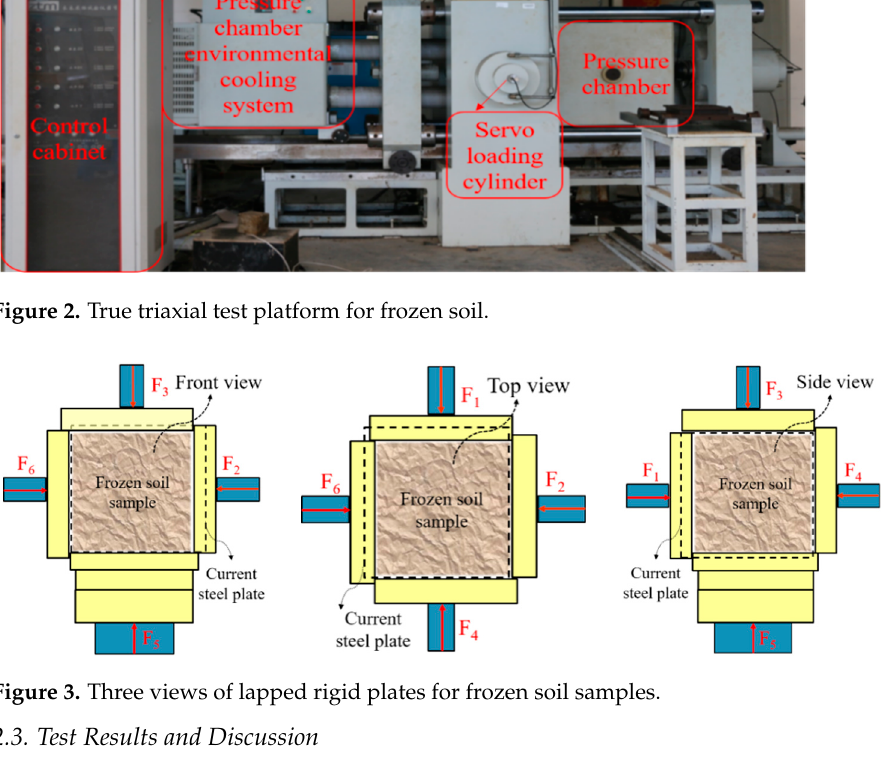
3 # Figure 4. True triaxial stress–strain and volume deformation curves of frozen calcareous clay. Figure 4 shows that the equivalent stress–strain relationship of the frozen calcareous clay was divided into three stages. The first was the linear elastic stage. Due to the high water content in the three selected samples, the samples were consolidated and frozen for a long duration. When the first principal strain was less than 0.5%, there was a certain instantaneous strength between the soil particles and cementation between the soil parti- cles and ice crystals. Frozen soil samples exhibited good integrity and resistance to small deformations and rapid stress growth. The second was the plastic hardening stage. Dur- ing this period, due to the increase in stress, the phenomenon of ice crystal pressure melt- ing occurs. The soil and ice crystal particles, and pores reappeared in the frozen soil sam- ple. The sample became denser, the bearing capacity was further improved, and plastic deformation from the first principal strain occurred, reaching approximately 5%. The third was the strain hardening failure stage. The occurrence of this stage depended on the test loading conditions. As mentioned above, a six-direction independent rigid loading mode was applied to control the load applied to the frozen soil samples. Frozen soil typi- cally has certain residual stress after failure; if the frozen soil sample does not completely